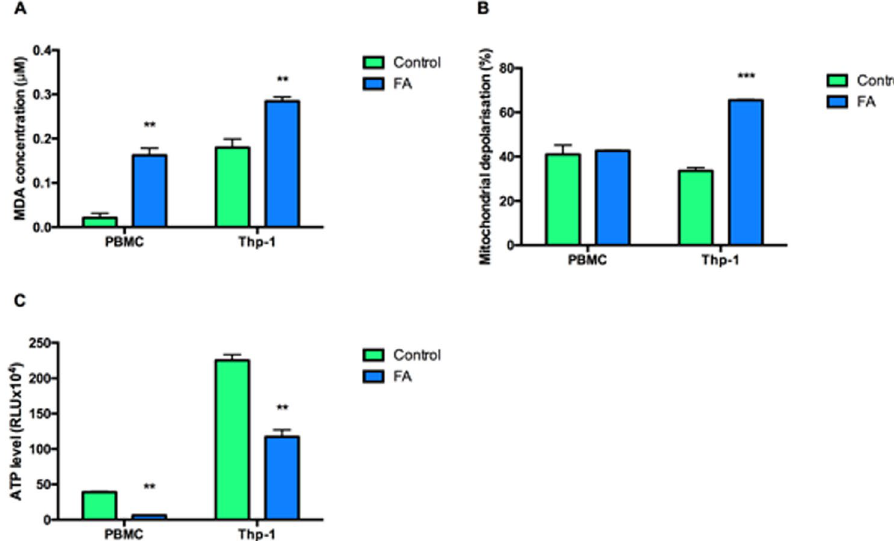
Figure 3. Effect of FA on the oxidative status and mitochondrial function in PBMCs and Thp-1 cells. FA increased MDA levels in both PBMCs and Thp-1 cells ( A ) had no effect on the mitochondrial membrane potential in PBMCs but increased depolarization of the mitochondrial membrane in Thp-1 cells ( B ). FA depleted ATP levels in PBMCs and Thp-1 cells ( C ). Data are expressed as mean ± SD. ** p < 0.005 relative to respective control; *** p < 0.0001 relative to respective control.